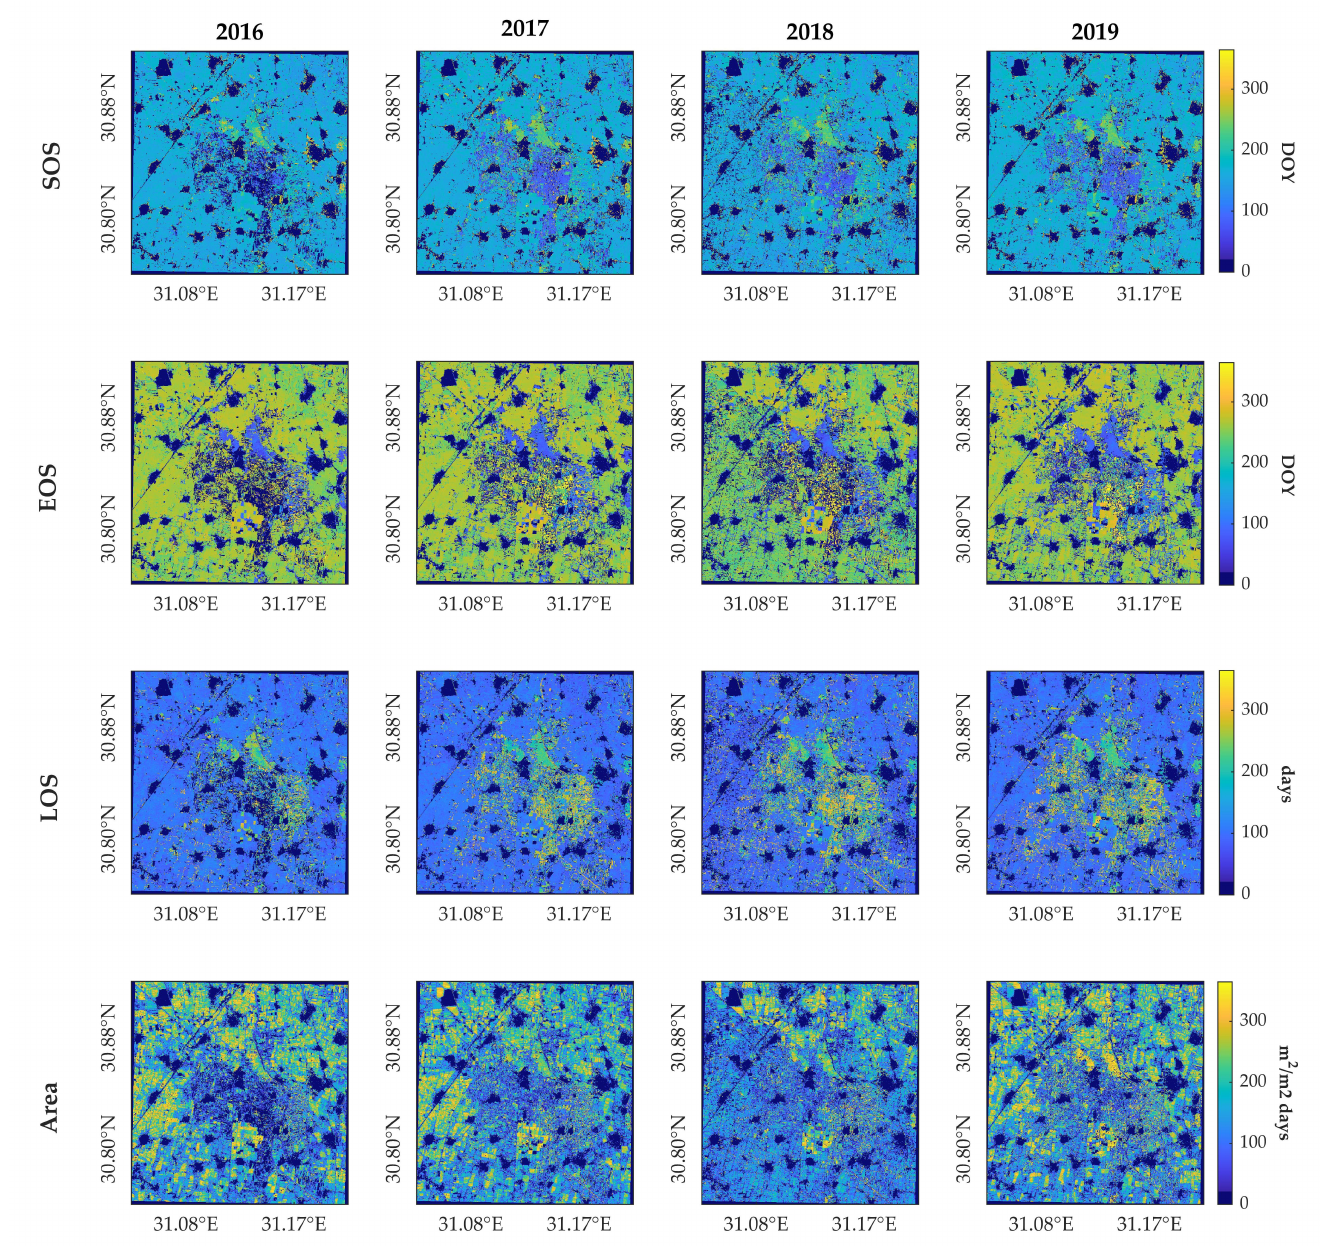
Figure 8. SOS, EOS, LOS and Area maps for the summer season from 2016 to